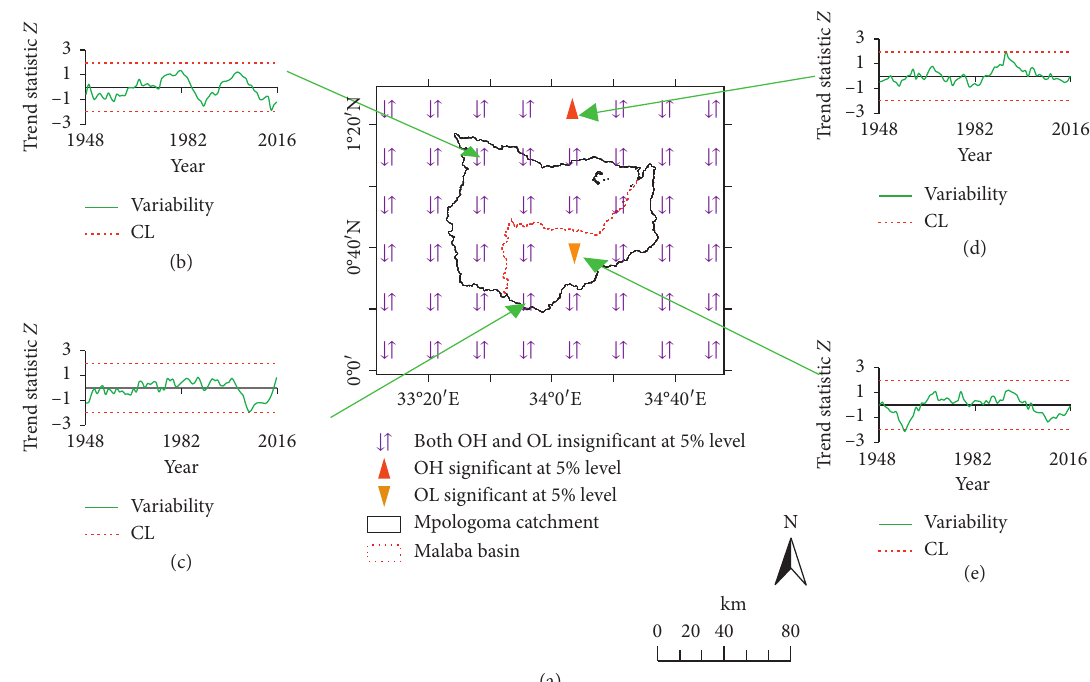
Figure 8: Spatial differences in the significance of evapotranspiration variability (a) and temporal variability (b–e) in OND evapo- transpiration at different locations of the study area.